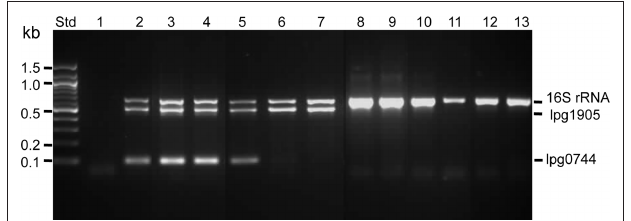
Figure 1 | representative gel showing simultaneous detection of lpg1905 , lpg0774, and 16SrrNA by multiplex PCr. Std, 100 base pair marker (Promega); Lane 1, no DNA control; Lane 2, L. pneumophila serogroup 1 strain 02/41; Lane 3, L. pneumophila serogroup 1 strain B6; Lane 4, L. pneumophila serogroup 1 strain CS1; Lane 5, L. pneumophila serogroup 1 strain 02/41; Lane 6, L. pneumophila serogroup 2–14 strain C11(1); Lane 7, L. pneumophila serogroup 2–14 strain C4(1); Lane 8, L. gormanii strain C9; Lane 9, L. anisa strain L041; Lane 10, L. gormanii 03/69; 11, L. longbeachae A4C5; 12, L. longbeachae ATCC33462; 13, L. longbeachae Atlanta 5. For lpg0774 (Gene Bank: AY688227) the upstream primer started at base 46: 5 ′ -TGCTAACAACCACTATCCCAAA-3 ′ and downstream primer started at base 202: 5 ′ - GTTTCAATAAAAGCGTGCTCCT-3 ′ . The upstream primer of lpg1905 (Gene Bank: NC_002942) started at base 328: 5 ′ -TTGCCTAAAACTCACCACAGAA-3 ′ and downstream primer started at base 857: 5 ′ -5 ′ ATGCCGCCCAAAATATACC-3 ′